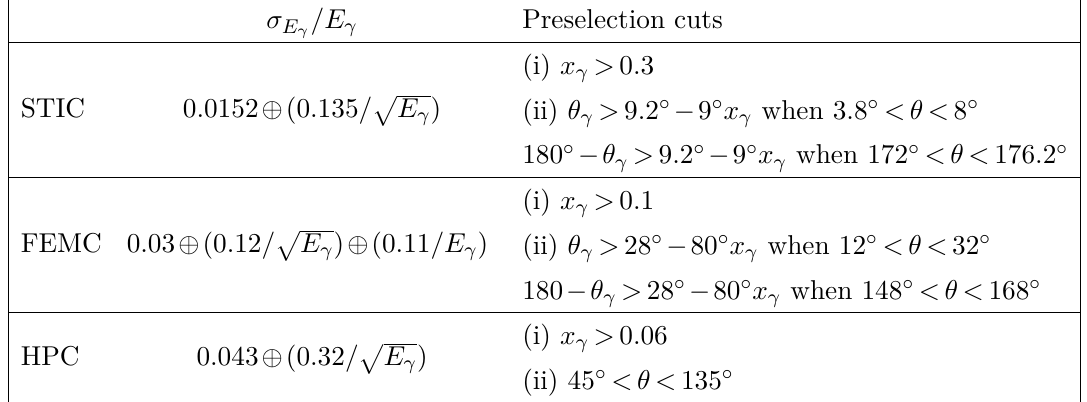
is in unit of GeV, and γ